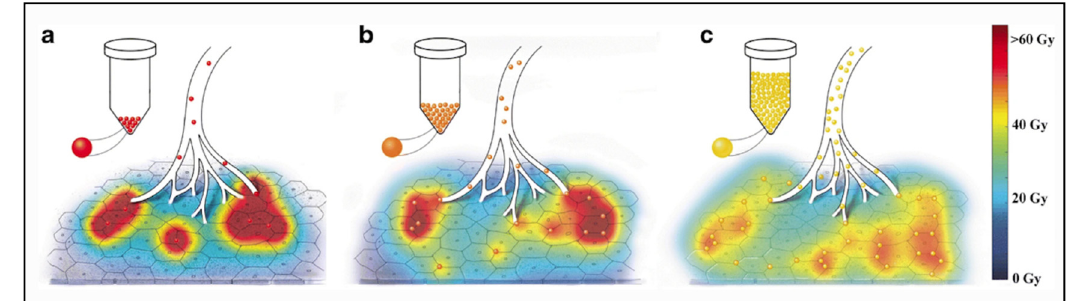
Figure 3. Artistic rendering of microscopic microsphere deposition at day 4 post-calibration ( a ), 8 post-calibration ( b ) and 12 post-calibration ( c ). Increased homogeneity of absorbed dose is apparent for glass microspheres injected at day 12 post- calibration (e.g., 193 Bq/microsphere, 5558 microspheres/mL). The proportion of the liver receiving a dose higher or equal to 40 Gy (red and yellow colors) was higher for glass microspheres injected at day 12 post-calibration ( c ). Reprinted from European journal of nuclear medicine and molecular imaging with permission of Springer Nature ( Eur. J. Nucl. Med. Mol. Imaging 2020, 47,